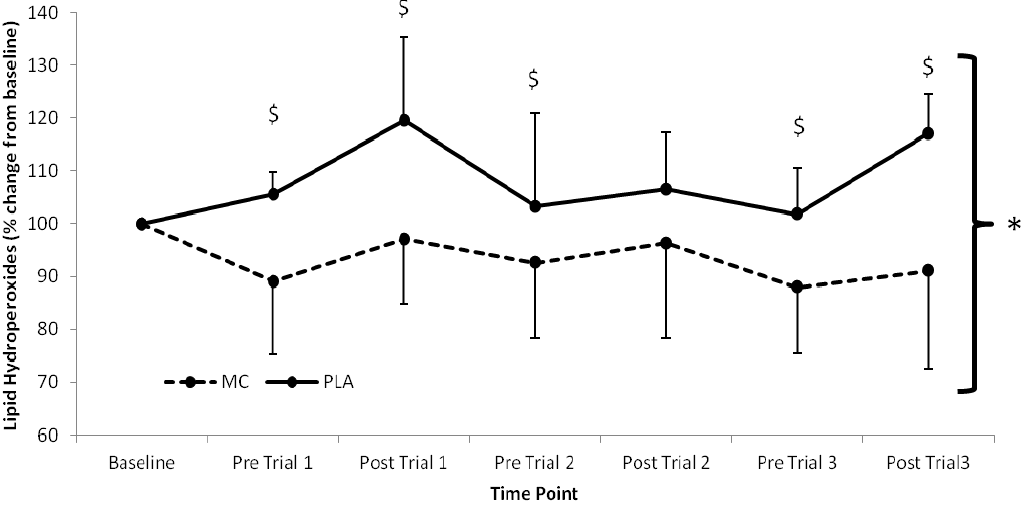
Figure 2. Serum lipid hydroperoxide responses (% Change from baseline) to Montmorency cherry concentrate (MC) and isoenergetic placebo (PLA). Absolute baseline values were 1.269 ± 0.085 and 1.189 ± 0.153 mmol mL −1 for MC and PLA respectively. * Significant group effect ( p < 0.05), $ Significant interaction effect ( p < 0.05); values are mean ±